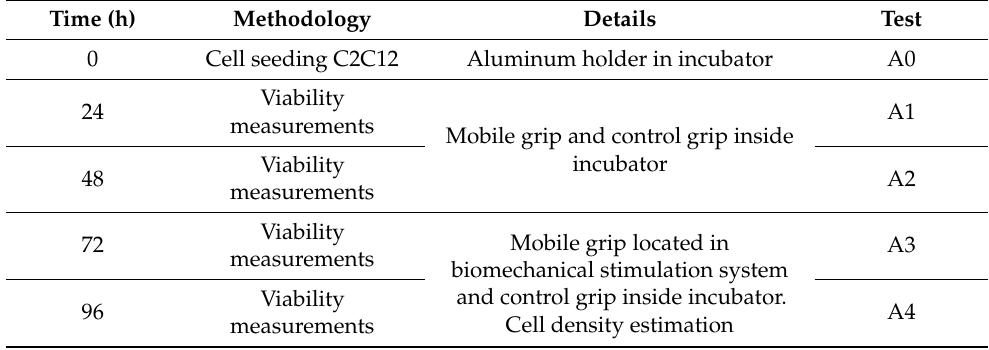
Table 1. Experimental procedure followed on the microfilament